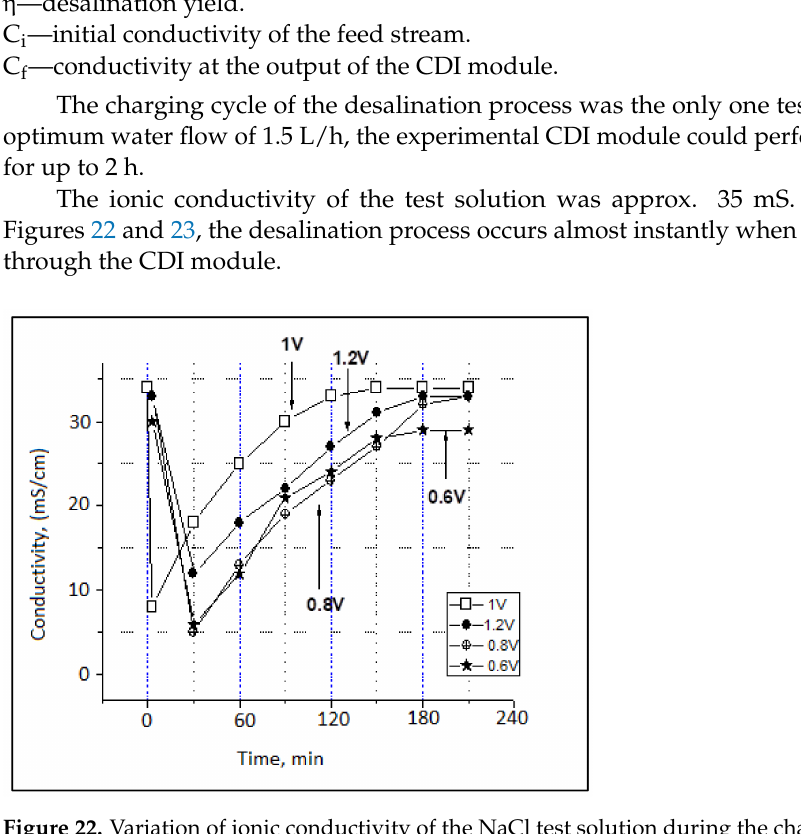
Figure 22. Variation of ionic conductivity of the NaCl test solution during the charge cycle.